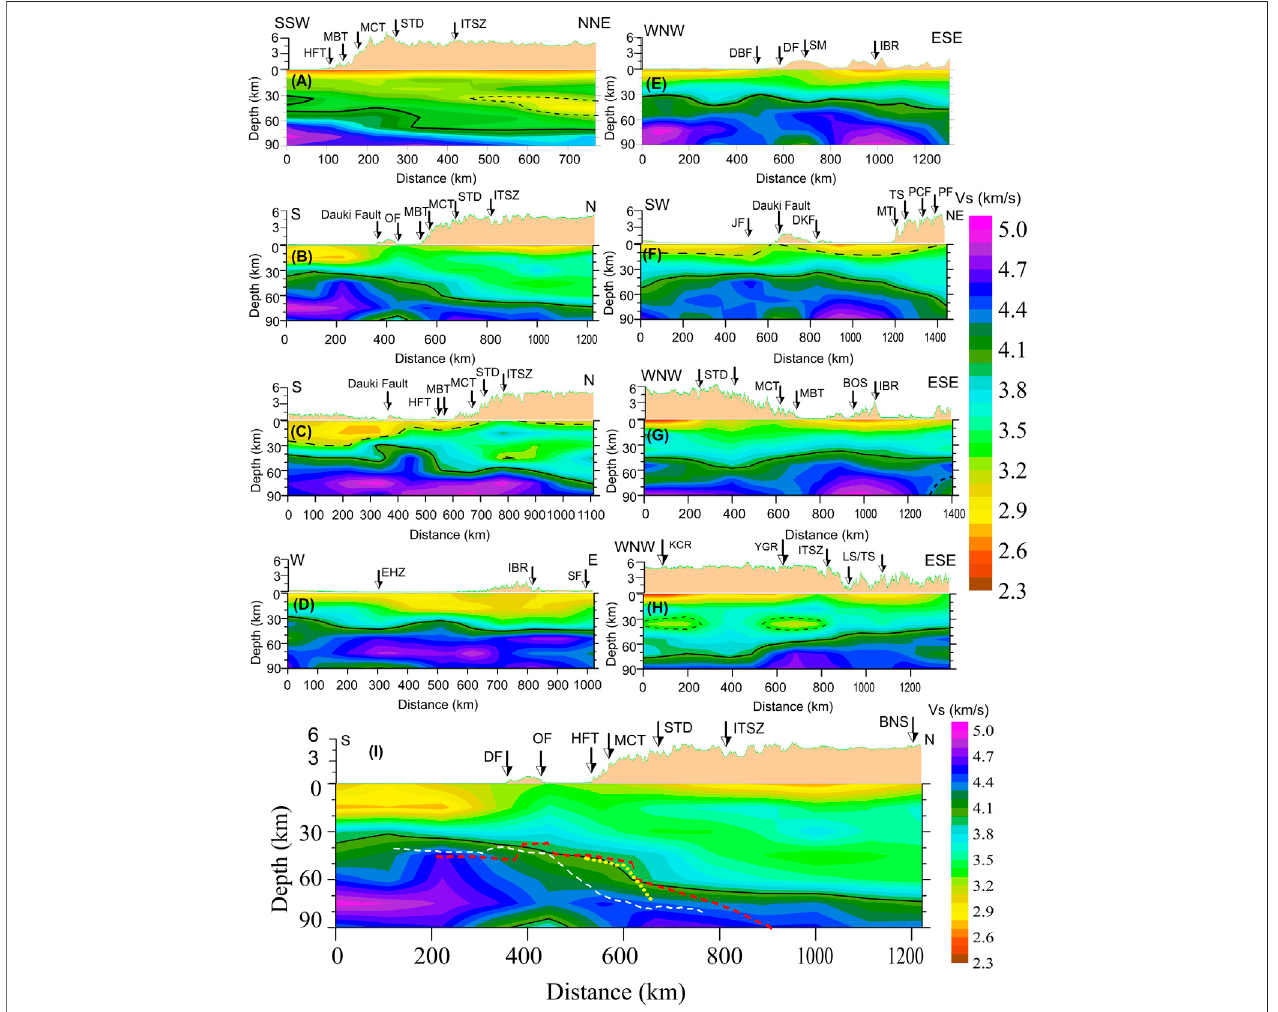
FIGURE 8| (A – I) Vsstructure alongdifferent pro fi les marked in Figure 1 . Legend: solid line — Moho discontinuity, dashed line — sedimentarylayer lower boundary, and dotted line — broken off part of uppermost mantle material (Panel 8G). Dashed lines in Panel 8H encompass low-velocity zones in mid-crust in Lhasa/south Tibet region. (i) Comparison of estimated Moho depth variation along pro fi le BB ’ (black line, Panel 8B) with that obtained by Priestley et al. (2008) (white dash line), Mitra et al. (2005) (red dash line), and Singer et al. (2017) (yellow dotted line). Abbreviations: JF: Jamuna fault; MT: Mishmi Thrust; TS: Tidding Suture; PCF: Po Chu fault; PF: Parlung fault; BOS: Belt of Schuppen; SF: Sagaing fault; LT/TS: Lohit Thrust/Tidding Suture, and other abbreviations as in Figure 1A